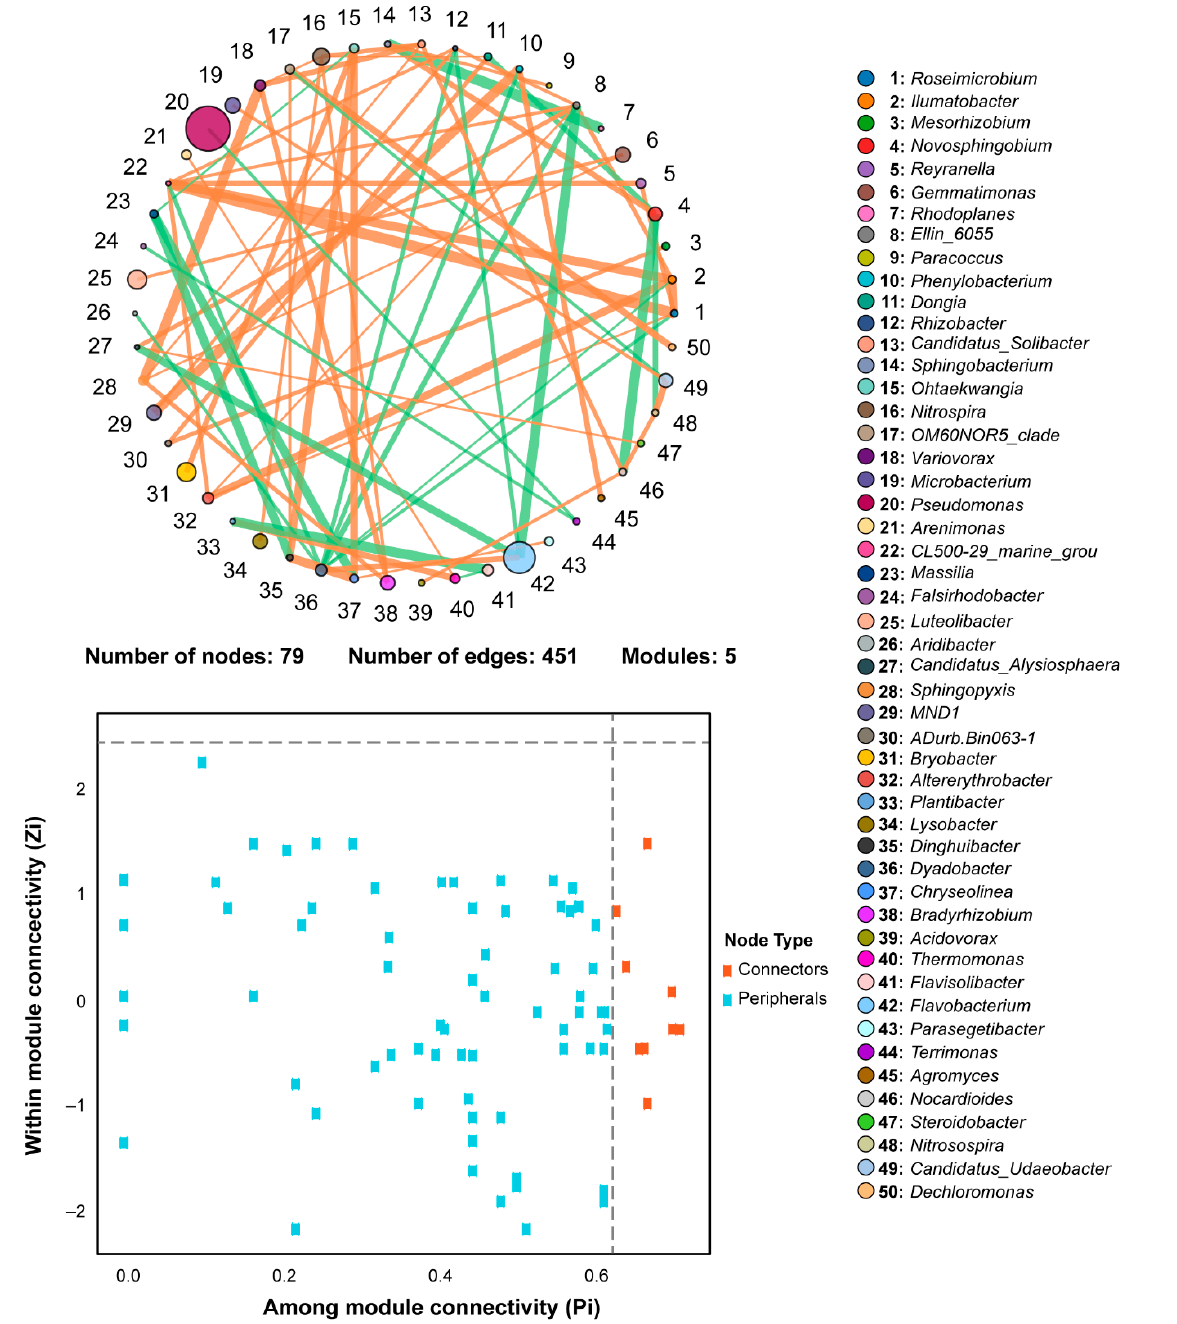
Figure 7. Co-occurrence network analysis of most abundant bacterial communities at genera level (correlation coefficient >0.1 and p <